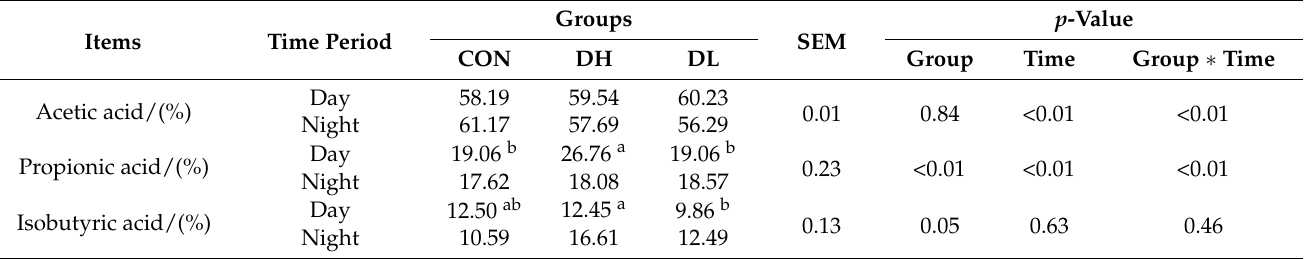
Table 4. Correlation between circadian rhythm and rumen VFA in HU